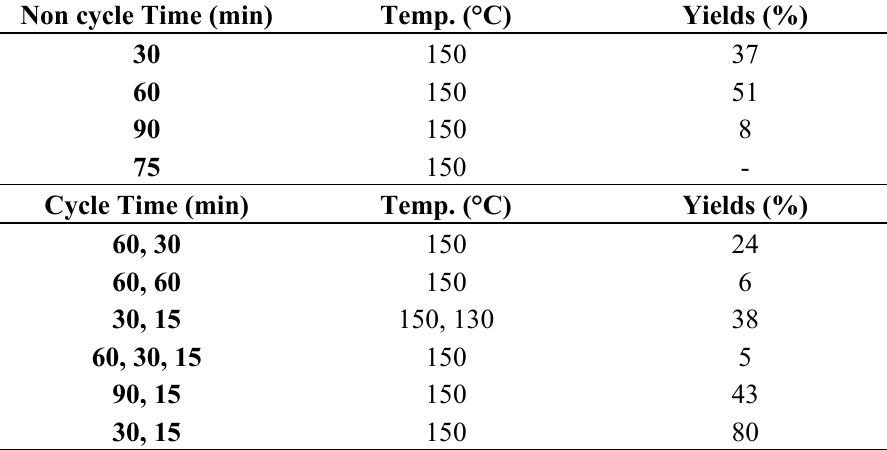
Table 4. Results from cycle vs . non cycles of 1-(5-carboxypentyl)-2,3,3-trimethyl-5-sulfo- 3 H -indolium salt (Entry